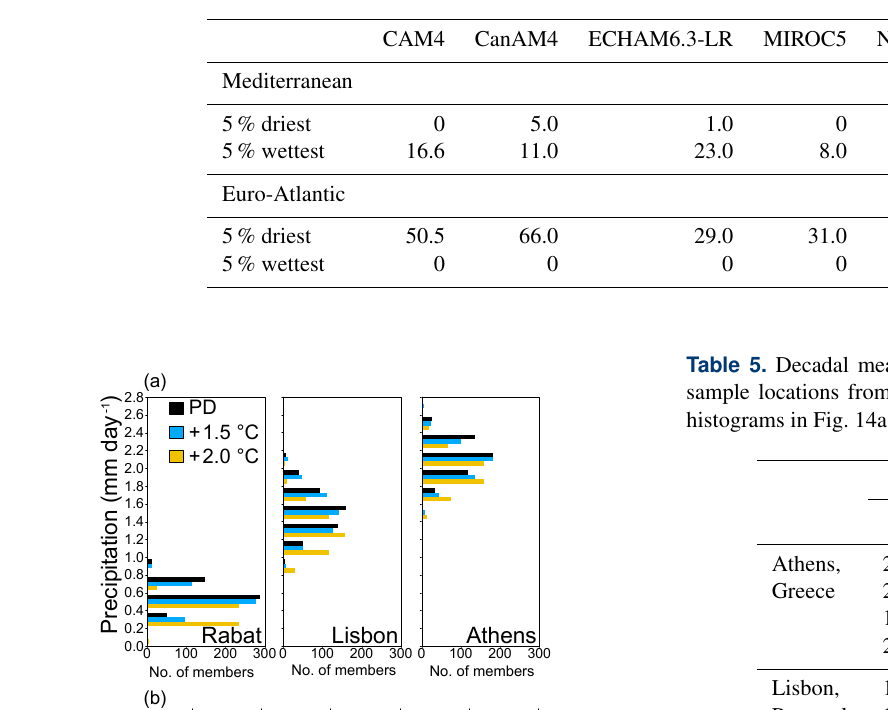
Table 4. Mapping of extreme decades in winter (DJF) precipitation from the 2.0 ◦ C experiment to the PD experiment. Values are the PD percentages corresponding to the 5% driest (5th percentile) and 5% wettest (95th percentile) limits in the 2.0 ◦ C experiment. Zero indicates that the 2.0 ◦ C extreme precipitation values do not exist in the PD distribution. The last column is a member-weighted multi-model mean. The Mediterranean region is defined by the box in Fig. 12d; the Euro-Atlantic region is defined by the box in Fig. 15b.